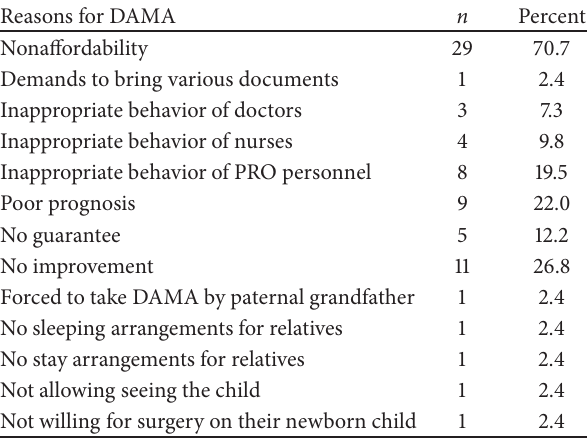
Table 2: Distribution of reasons for DAMAin the study group ( 𝑁 = 41